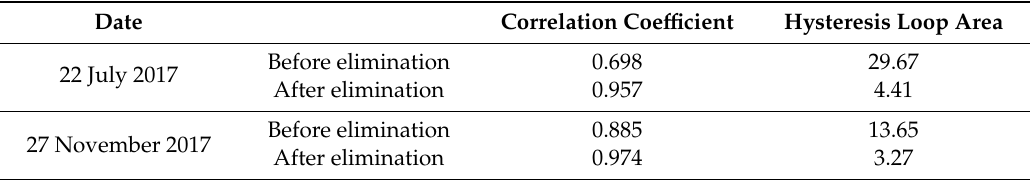
Table 1. Comparison of indicators before and after phase difference elimination.